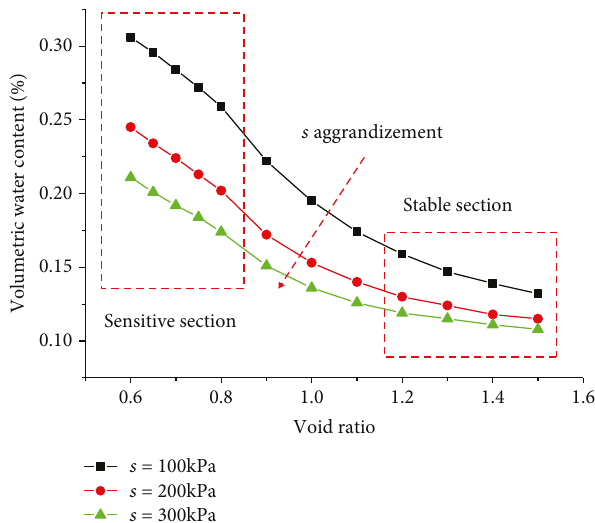
Figure 16: Relation of volumetric water content and void